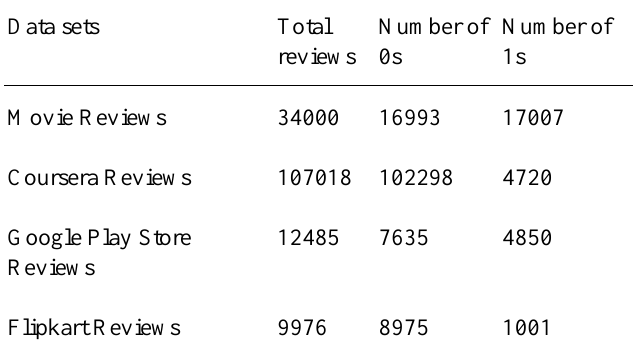
Table 1 Data sets Data